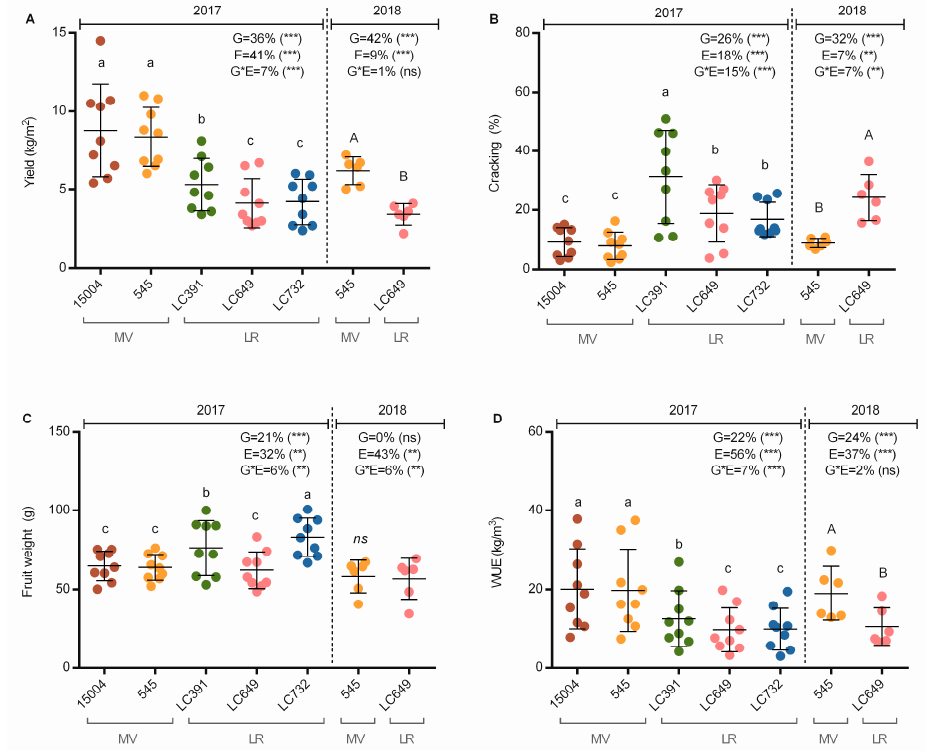
Figure 3. Differences between modern varieties (545, 15004) and landraces (LC391, LC649, LC732) in agronomic traits. ( A ) Yield, ( B ) cracking incidence, ( C ) fruit weight, ( D ) water-use efficiency (WUE). Mean ± SEM calculated from 2017 (Exp7–Exp16) and 2018 trials (Exp1-Exp6). Within graphs, and for each year, different letters (2017, lowercase; 2018, capital letters) indicate significant differences between genotypes (Student–Newman–Keuls, p < 0.05). G, E, and G*E percentages indicate the relative contributions of genotype, environment, and genotype-by-environment interaction, respectively, to the total observed phenotypic variation. Level of significance: * p < 0.05; ** p < 0.01; *** p < 0.001; ns, not significant ( p > 0.05).